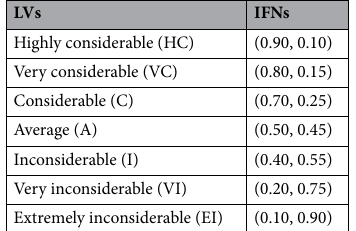
Table 2. Performance rating of DMEs in form of LVs.